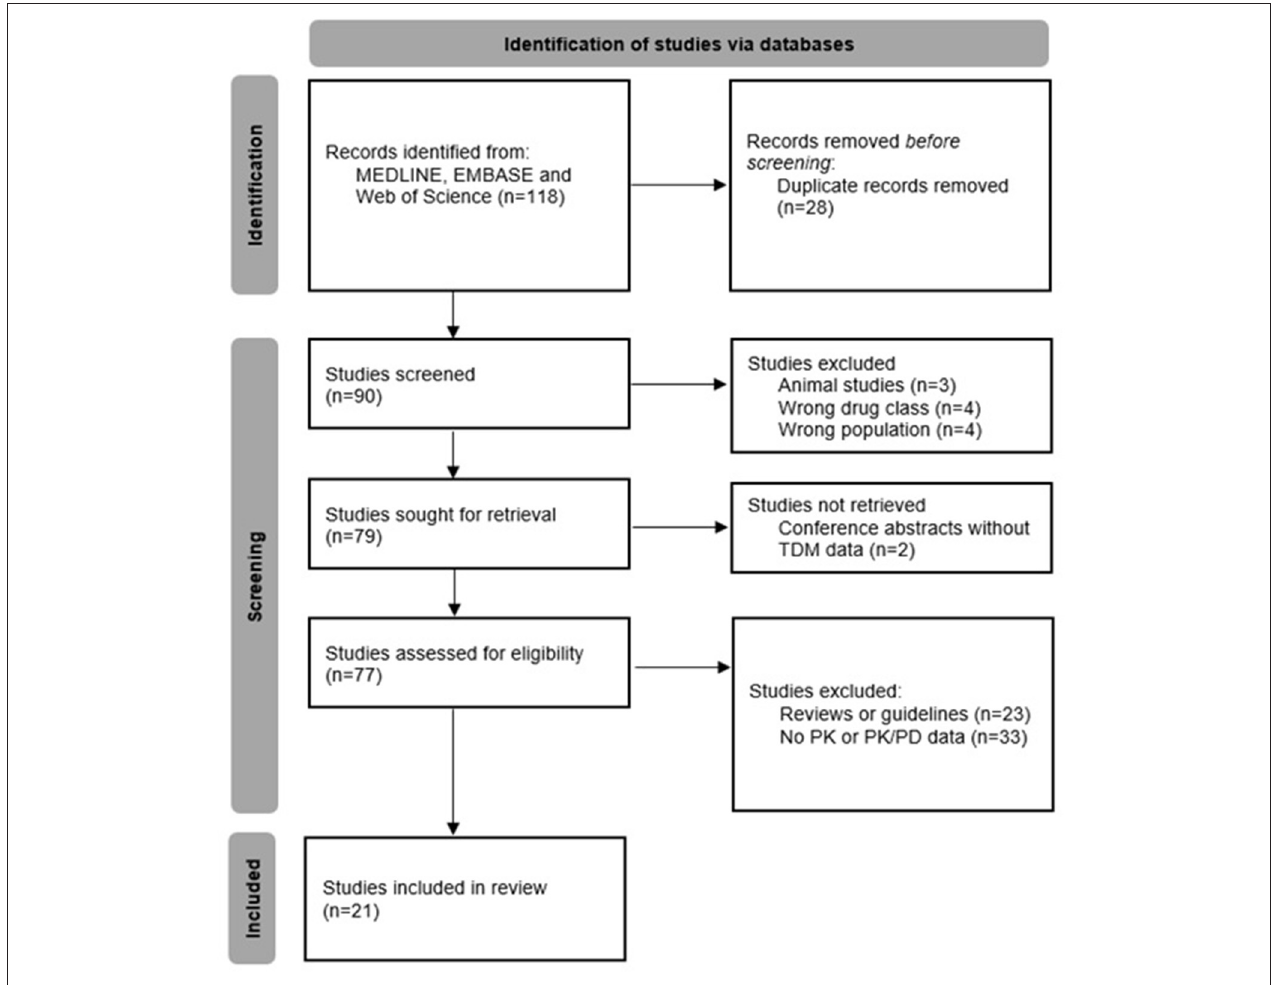
FIGURE 1 | Flowchart describing the study selection process.